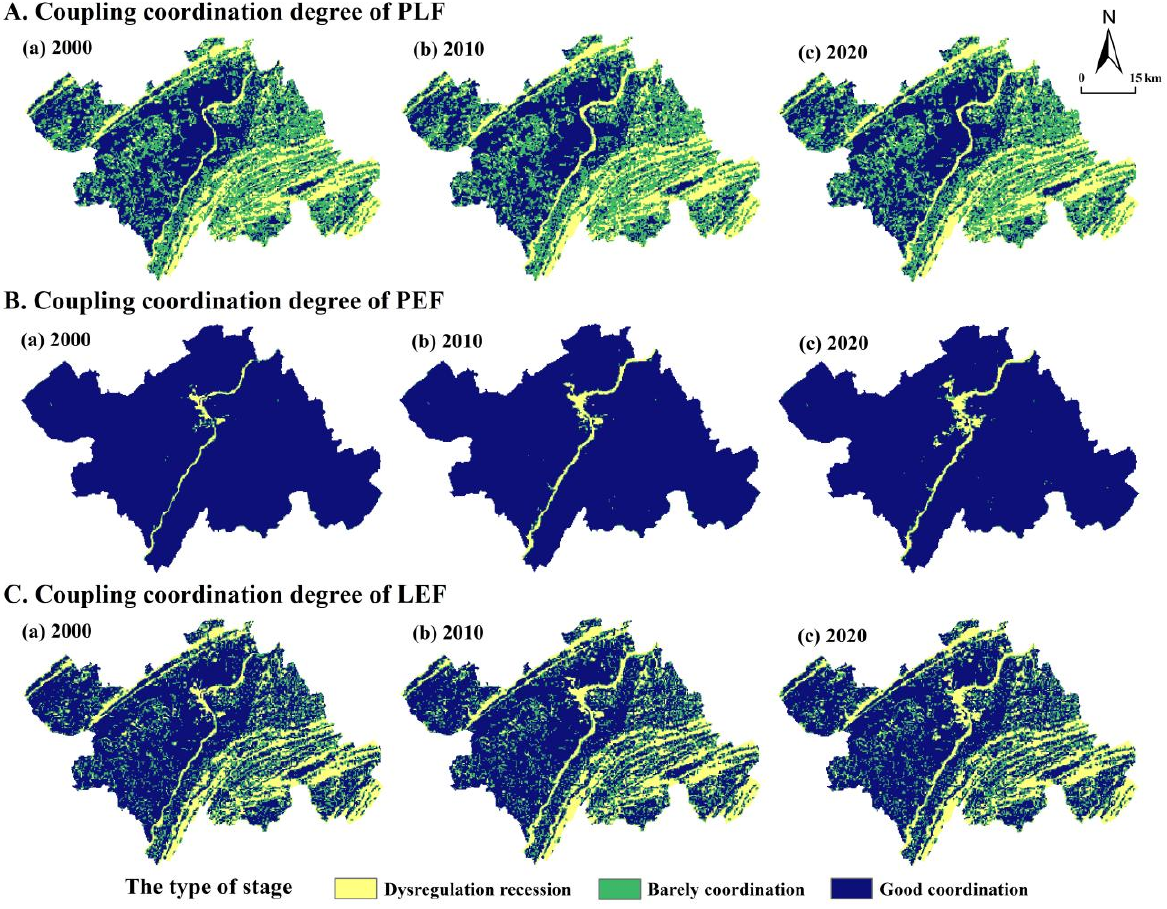
Figure 7. Coupling coordination degree of PLE(A), PEF(B), and LEF(C).